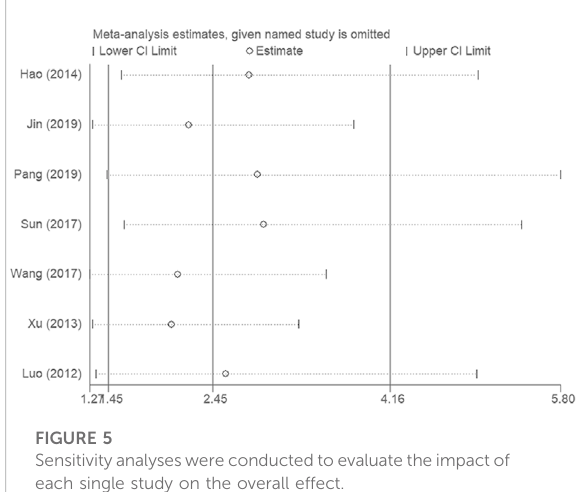
FIGURE 5 Sensitivityanalyseswereconductedtoevaluatetheimpactof each single study on the overall